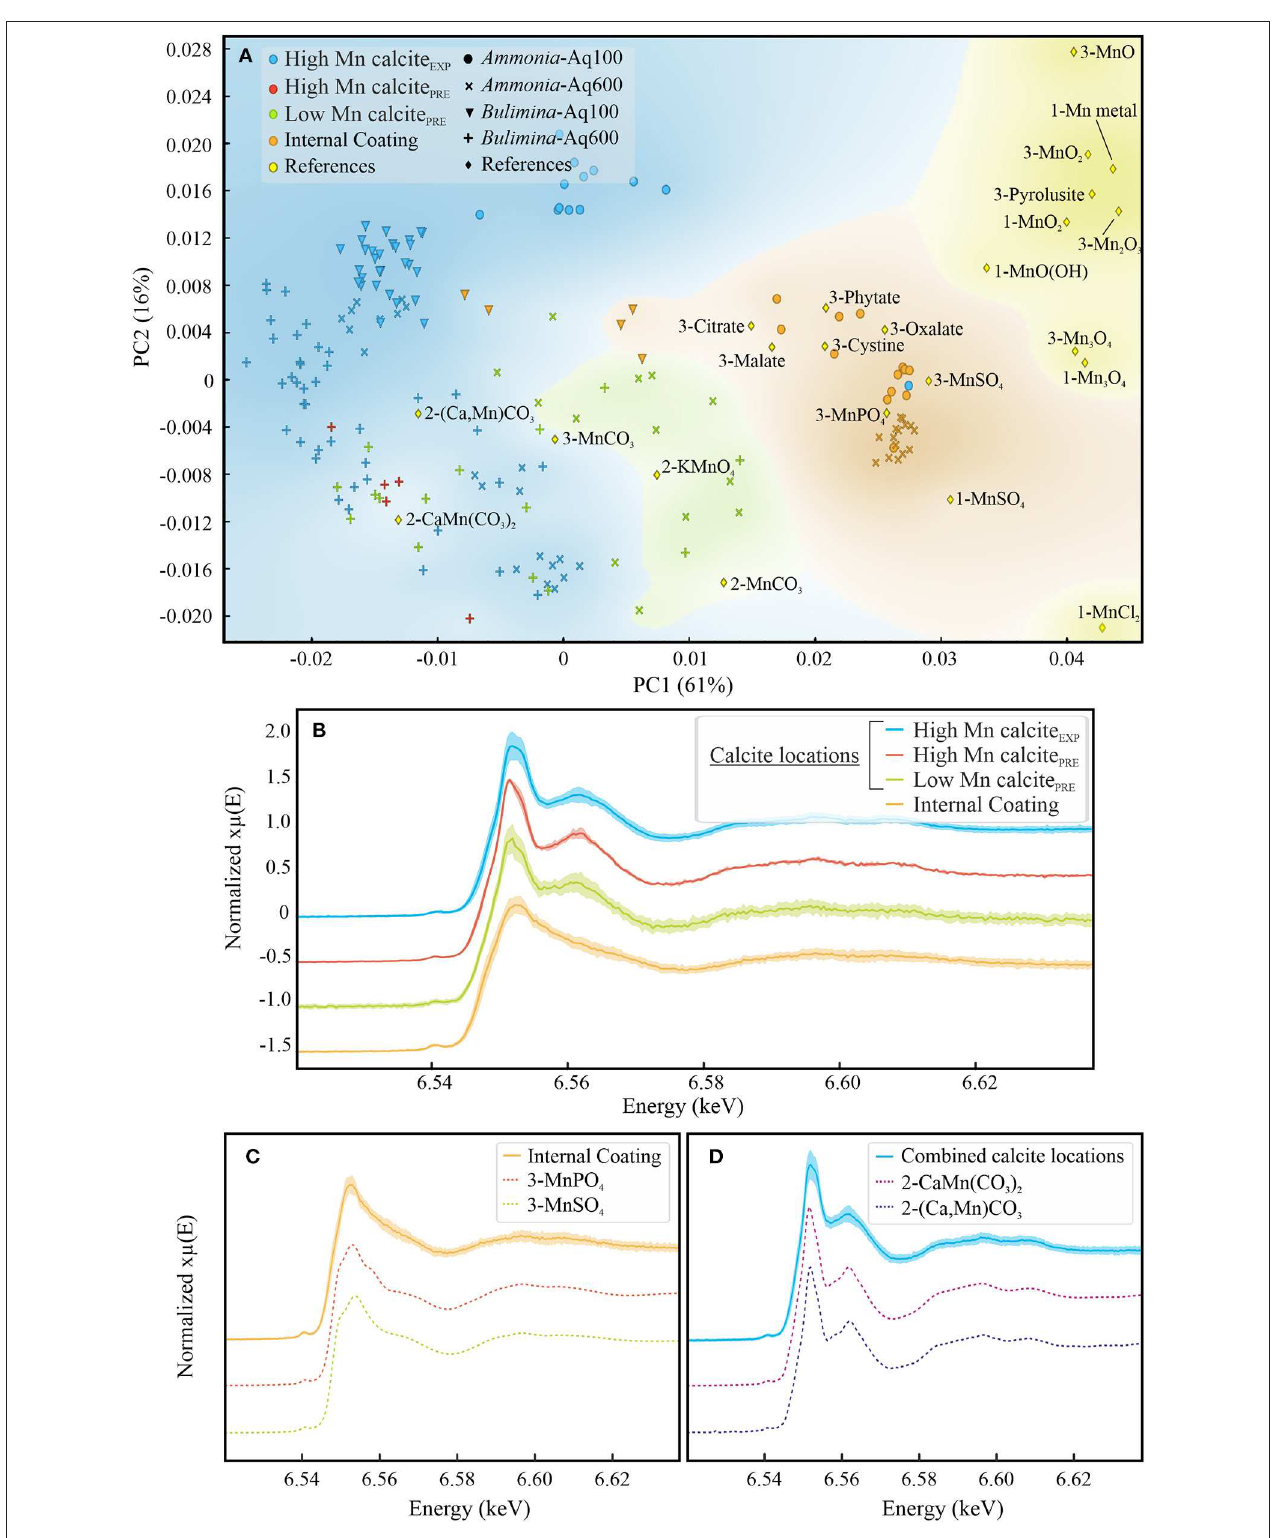
FIGURE 10 | Summary of µ XANES analyses. PCAs performed on all normalized (second derivative) spectra (both species, both aquaria, and all locations) and on reference spectra (A) . Average spectra ± SD for the different locations (“high Mn calcite EXP ,” “high Mn calcite PRE ,” “low Mn calcite PRE ,” and “internal coating”; B ). The average spectra ± SD of (C) “internal coating” and (D) calcite locations (i.e., “high Mn calcite EXP ,” “high Mn calcite PRE ,” and “low Mn calcite PRE ” spectra combined), plotted with spectra of the reference material. Please note that for panels (B–D) , a shift has been applied on the y -axis to improve readability. µ XANES, micro-X-ray absorption near-edge structure; PCA, principal component